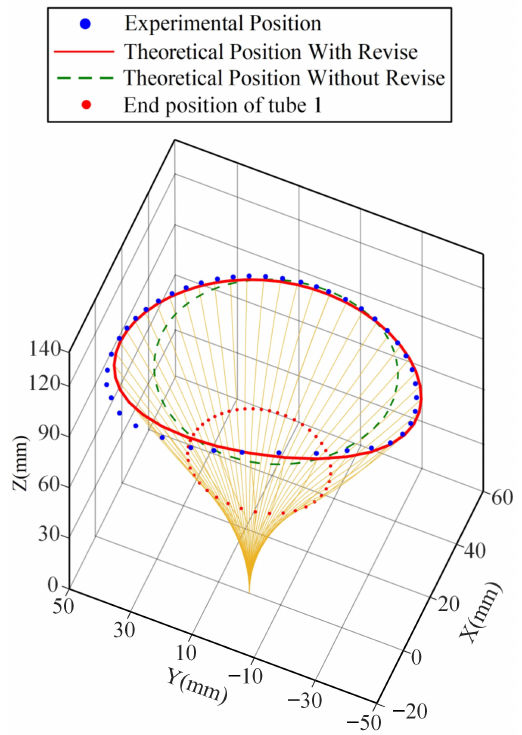
Figure 10. Comparison of the outer tube rotation path of the improved model and the previous